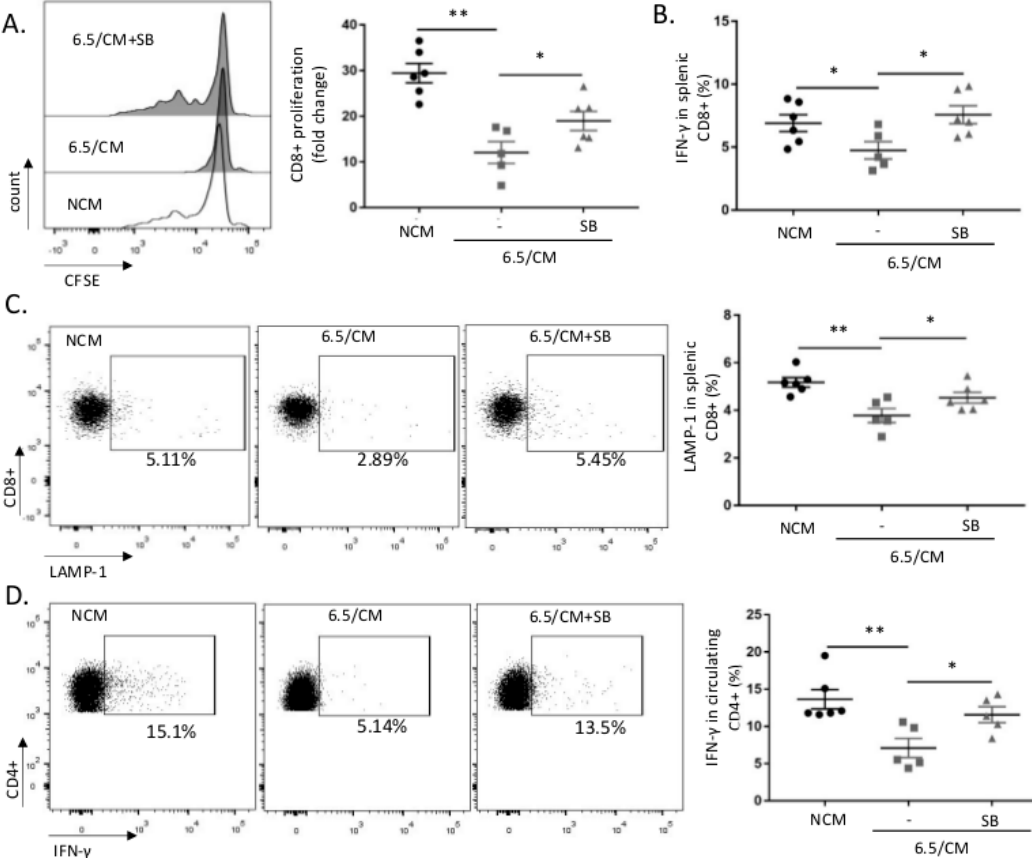
Figure 6. The acidic mesothelioma milieu alters the ability of dendritic cell (DC)-based vaccine to induce anti-tumor T cell activation in vivo. ( A – C ) CD8 + splenocytes collected at day 14 post-vaccination (i.e., NCM, 6.5 / CM, and 6.5 / CM + 5 µ M SB-431542, see Figure 5) were re-exposed to Ab1 mesothelioma cells. Proliferation of CD8 + splenocytes was detected based on CFSE dilution ( n = 6, * p < 0.05, ** p < 0.01) ( A ) and activation was probed based on interferon gamma (IFN- γ ) production ( B ) and lysosomal-associated membrane protein-1 (LAMP-1) staining ( C ) ( n = 6, * p < 0.05, ** p < 0.01). ( D ) IFN- γ production in circulating CD4 + lymphocytes stimulated with phorbol myristate acetate (PMA) / ionomycin ( n = 6, * p < 0.05, ** p < 0.01).